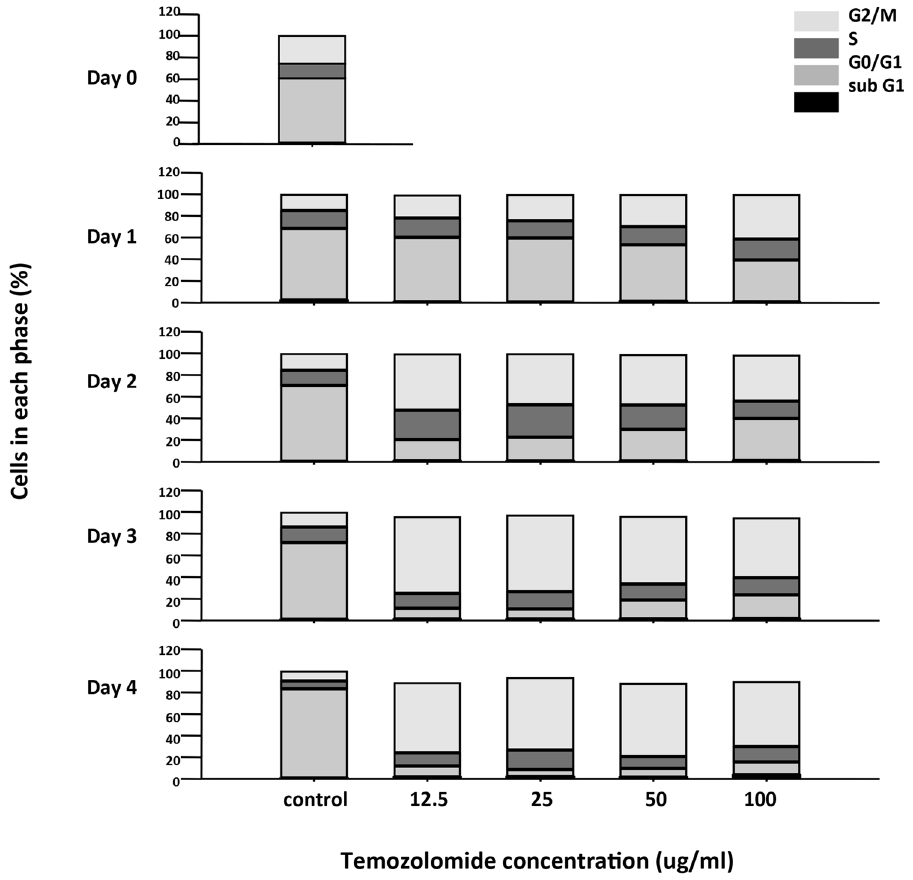
Figure 2. Cell cycle progression after TMZ treatment of human U87 glioblastoma cell lines analysis by FACS. Bar charts illustrating the proportion of cells at different stages in the cell cycle derived from the decomposition of flow cytometry histograms. U87 cells have been treated with vary concentration (0 μ g/ml, control; 12.5 μ g/ml; 25 μ g/ml; 50 μ g/ml; 100 μ g/ml) TMZ for different time frames: 0 day, 1 day, 2 days, 3 days and 4 days. The U87 cells treated with TMZ were arrest in G2/M stage in dose and time-dependent